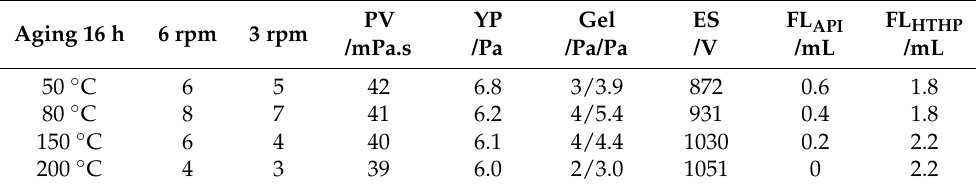
Table 1. Performance of oil-based drilling fluid.